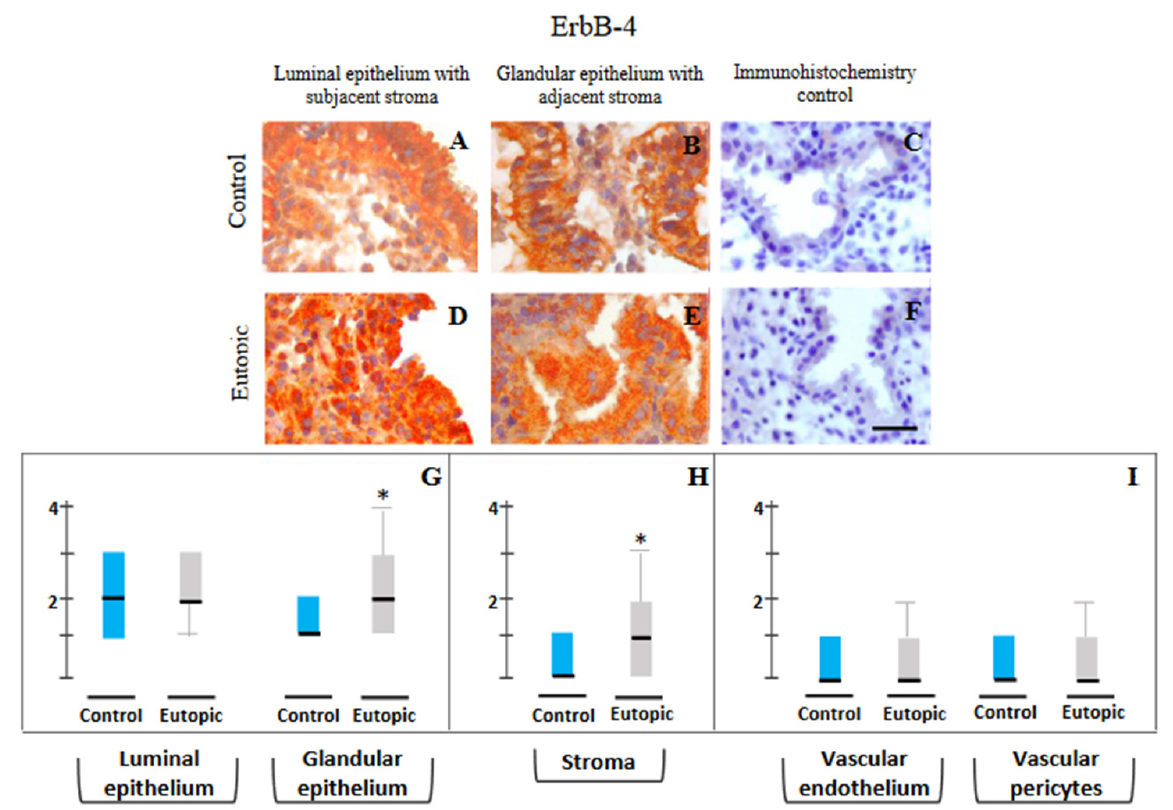
Figure 5. Representative photomicrographs of ErbB-4 ( A – F ) expressions in luminal epithelium along with subjacent stroma ( A , D ), and glandular epithelium ( B , E ) in endometrial samples collected from endometriosis-free control women of group 1 ( A – C ) and stage IV ovarian endometriosis pa- tients of group 2 ( D – F ) and their semi-quantitative assessments shown in the form of box plots of 10–90 percentile distribution of scores, along with median values ( G – I ). High levels of cytoplasmic distribution besides membranous localization of ErbB-4 are seen, more predominantly in eutopic endometrial epithelium ( D , E ). A marginally higher trend of ErbB-4 immunopositivity is seen in the glandular epithelium and stromal components of eutopic endometrium as compared to control endometrium ( G , H ). Controls for immunohistochemistry staining were attained by omitting the primary antibody ( C ) or the secondary antibody ( F ). * p < 0.05. Bar: 75 µ m ( A , B , D , E ), 100 µ m ( C , F ).